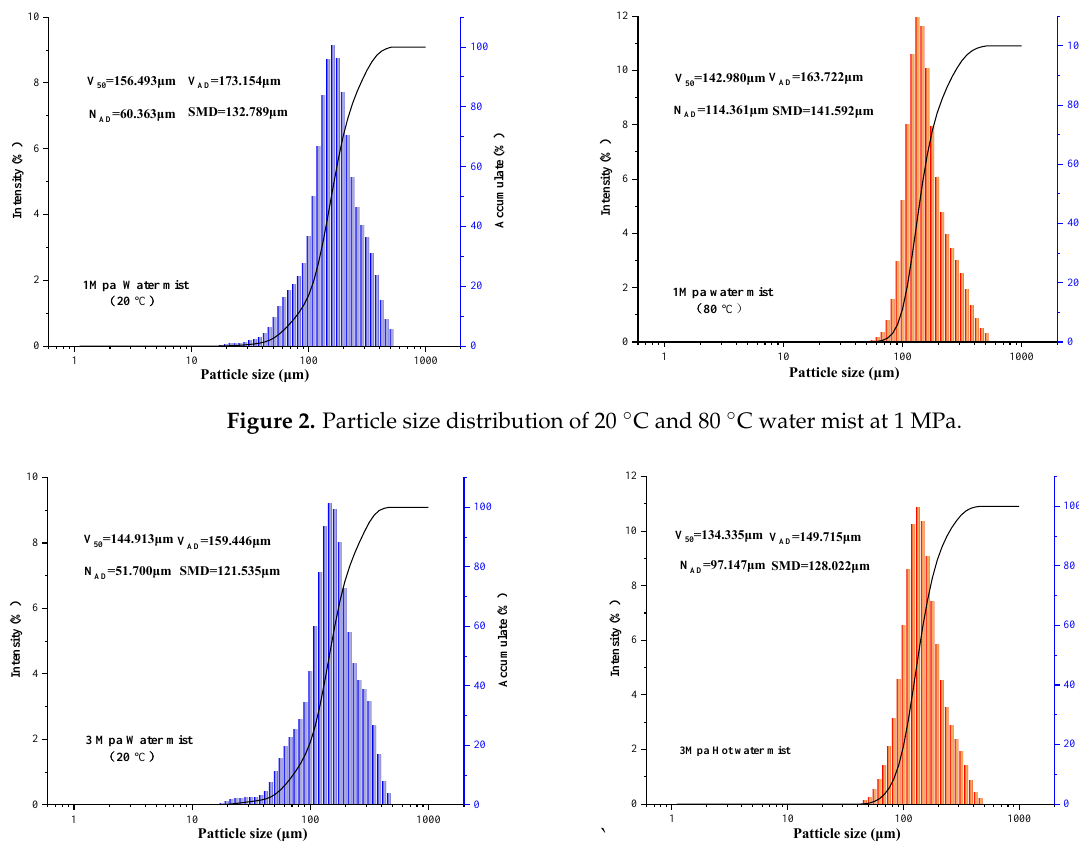
Figure 3. Particle size distribution of 20 °C and 80 °C water mist at 3 MPa.